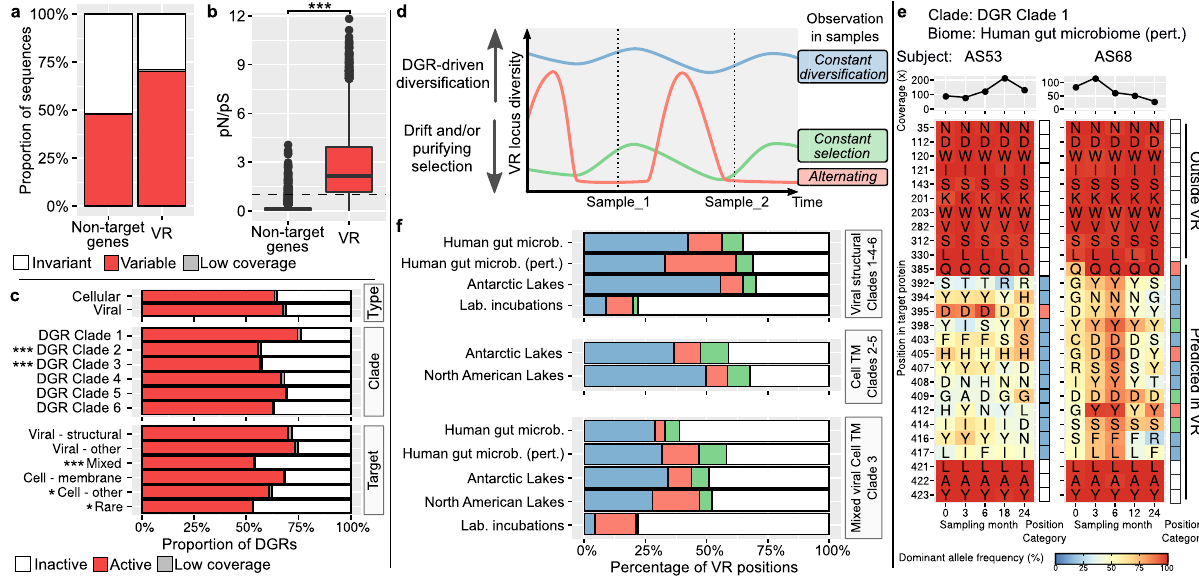
Fig. 3 Diversity patterns associated with DGR target loci. a Proportion of genes with ≥ 1 SNV observed (synonymous or non-synonymous), for both non- target genes within 10 kb of a DGR RT (left) and VR loci (right). “ Low coverage ” category includes cases in which the coverage of the VR region was signi fi cantly lower than that of the surrounding genes, suggesting that the read recruitment may be only partial, and the population diversity in the VR cannot be reliably inferred (see Supplementary Fig. 11). b Distribution of pN/pS values for genes with ≥ 1 synonymous SNV, for both non-target genes and VR loci. A dashed line indicates pN/pS = 1. Boxplot lower and upper hinges correspond to the fi rst and third quartiles, whiskers extend no further than ±1.5 times the interquartile range. pN/pS distributions for non-target genes and VR loci were compared using a Kruskal – Wallis test (*** p -value < 2.2E − 16 and Cohen ’ s d effect size >1.7). c Proportion of DGRs estimated as “ active ” vs. “ inactive ” based on enrichment of VR loci in non-synonymous SNVs compared to surrounding genes, across different DGR classi fi cations. Groups with a signi fi cantly lower proportion of active sequences (Chi-squared test of independence) are highlighted with star symbols (Bonferroni-corrected p -values: *<1E − 03, **<1E − 05, ***<1E − 10). d Schematic representation of the two competing forces exerted on VR loci: purifying selection and DGR diversi fi cation. Three examples of possible DGR activity levels are indicated in color, with the resulting observations across a time series ( “ Sample_1 ” and “ Sample_2 ” ) summarized in the right column. e Example of diversity and changes observed for one DGR target across two-time series datasets. For each position, the corresponding amino acid is indicated in the main heatmap with its frequency within the population indicated in color. The right panel indicates the category of the position, colored as in panel ( d ), based on within-sample entropy, between-samples cosine distances, and the number of amino acid changes in the time series (see Supplementary Note 12). The top panel indicates the median coverage of all positions in each sample. For reference purposes, ten random positions from the same protein outside of the predicted VR are included. f Distribution of VR positions into “ activity ” categories (colored as in panel ( d )) across different biomes and clades. Cases with <50% of variable positions and <5% of amino acid changes were considered as “ low DGR activity ” and colored in white. Only groups for which ≥ 10 DGRs were available are